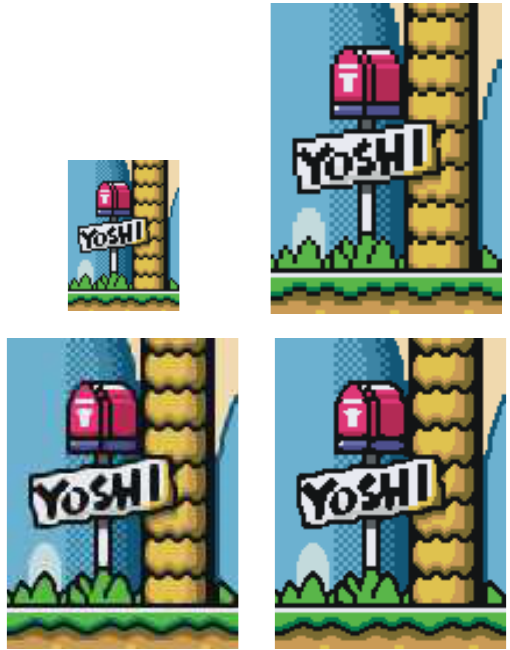
Fig. 5. At the top: the original ‘mailbox’ image (left) and the nearest neighbour interpolated image for magnification by a factor 2 (right), at the bottom: the result of our new morphological interpolation method (left) and our method, giving as result a colour image with no new colours (right).